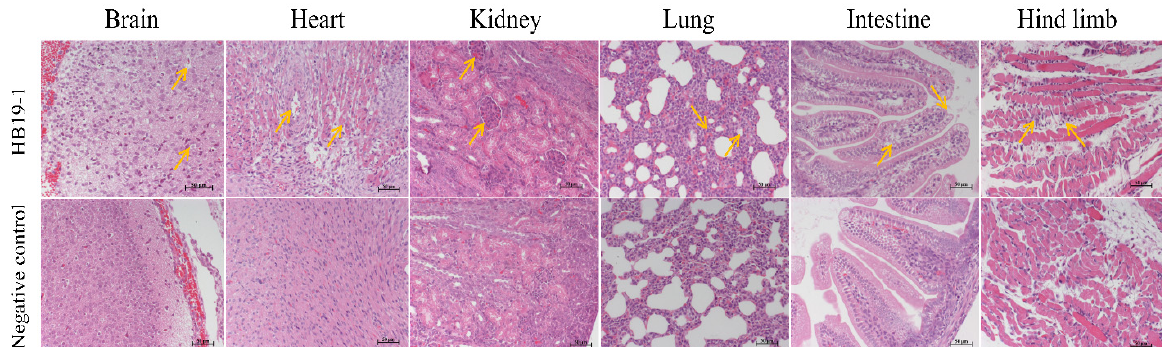
Figure 4. Histopathology analysis of HB19-1-infected ICR mice after 3 days infection. Heart, liver, spleen, lungs, kidneys, brain, intestines, and muscle tissues of the BEV HB19-1-infected mice were obtained. At the indicated time points post-infection, the paraffin sections of tissues were stained with haematoxylin–eosin (HE) and observed under a light microscope. All observations were performed at 200× magnification. Black arrows indicate the typical lesion.